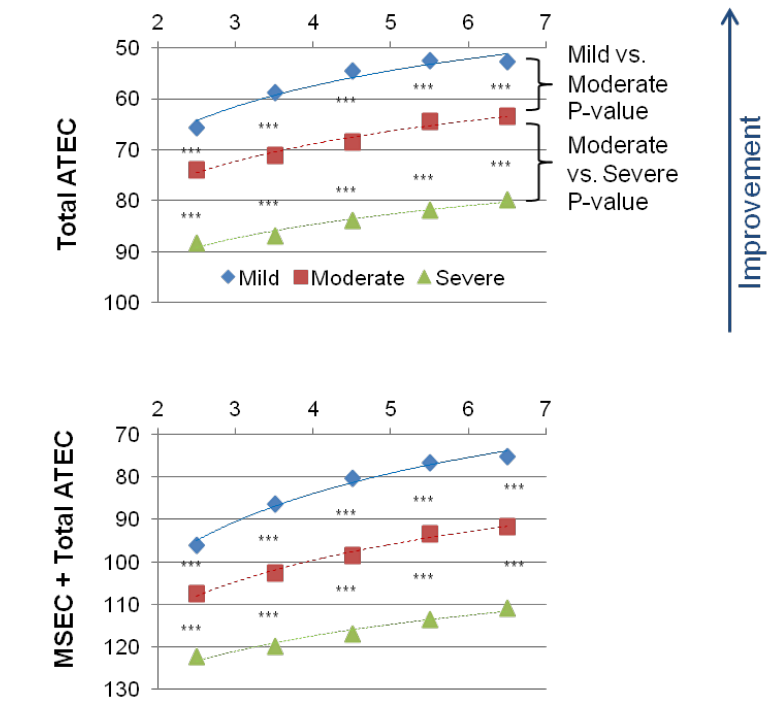
Figure 2. Averaged scores in five subscales for the mild, moderate, and severe ASD groups. Lower scores indicate symptom improvement. ( A ) The total ATEC score, which is the sum of the Expressive Language score, Sociability score, Cognitive awareness score, and Health score. ( B ) The sum of the total ATEC and the MSEC scores (i.e., the sum of all five subscales). The p -value is marked: *** <0.0001. Table 8. Averaged Total ATEC + MSEC score for the mild, moderate, and severe ASD groups. A lower score indicates symptom improvement. The data are presented as the mean (SD).